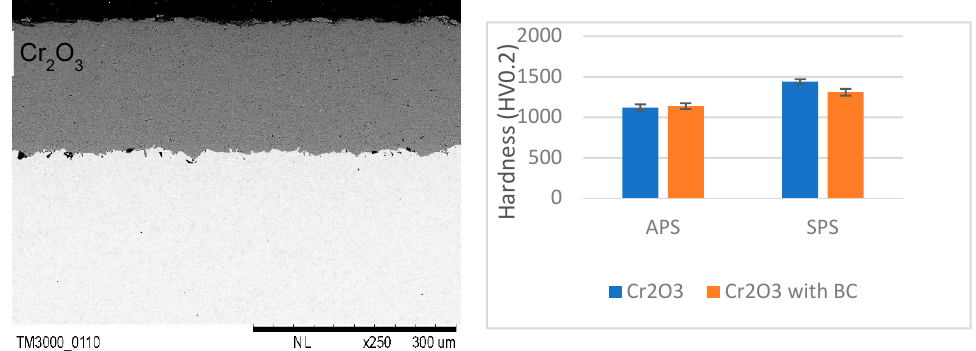
Figure 9. Preliminary results with SPS chrome oxide coatings revealing ( left ) dense coatings with good microstructural integrity and ( right ) hardness levels that are comparable or exceed those typically achieved by conventional powder-derived plasma spray coatings. (APS = atmospheric plasma spray).